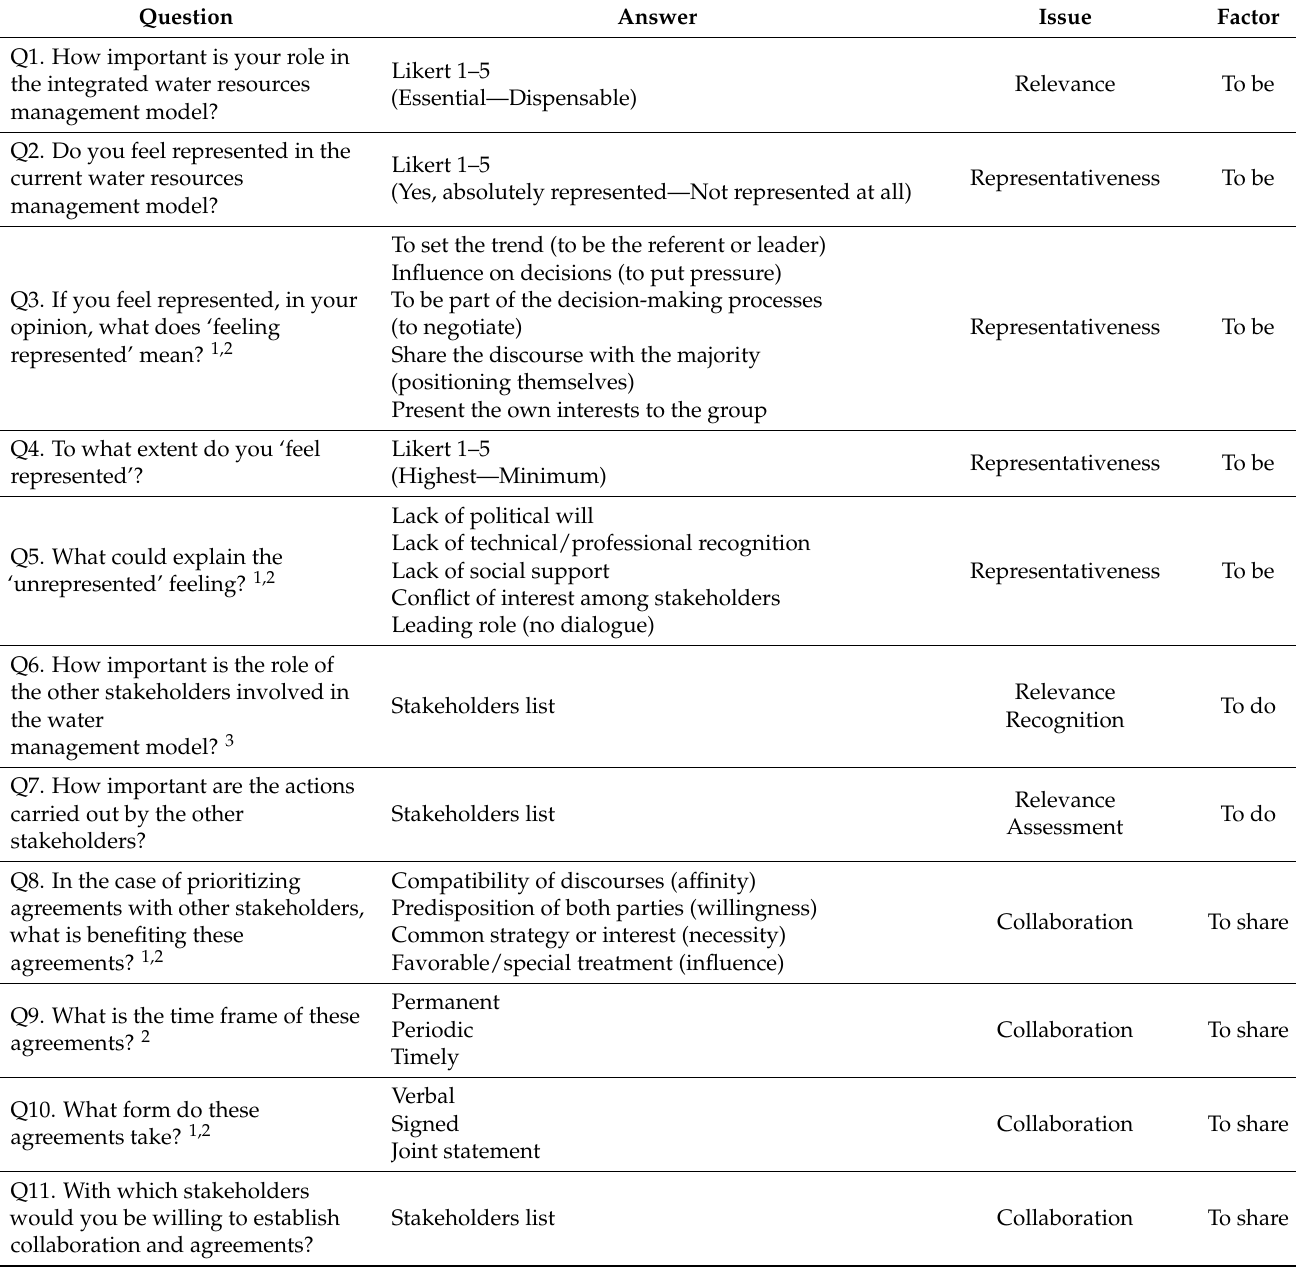
Table 2. Questions included in the questionnaire to